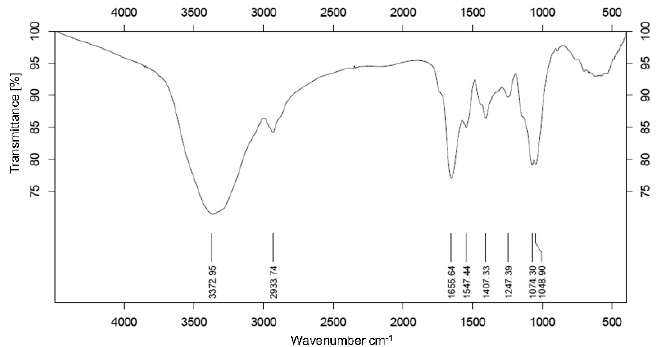
Figure 2. FT-IR spectrum of NNP-2.